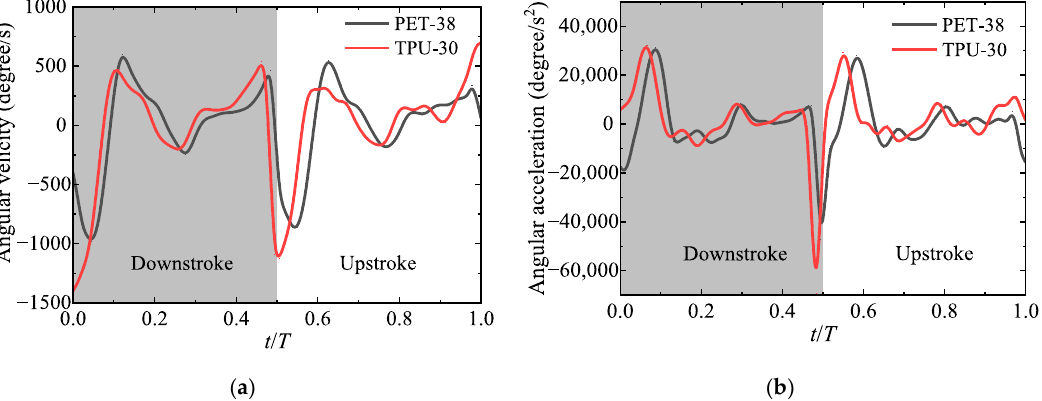
Figure 15. Angular velocity and angular acceleration of the angle of attack at 0.75 R for 22 Hz. ( a ) Angular velocity; ( b ) Angular acceleration.